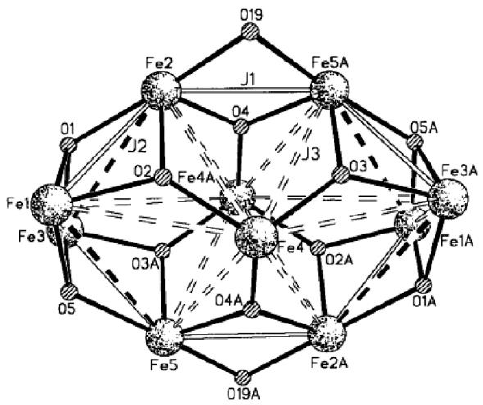
Figure 15. The molecular skeleton of { Fe 10III } cage and exchange coupling scheme. Fe-O bonds shown as full lines; J 1 shown as open lines; J 2 shown as dashed full lines; J 3 shown as dashed open lines (adapted with permission from [66]).